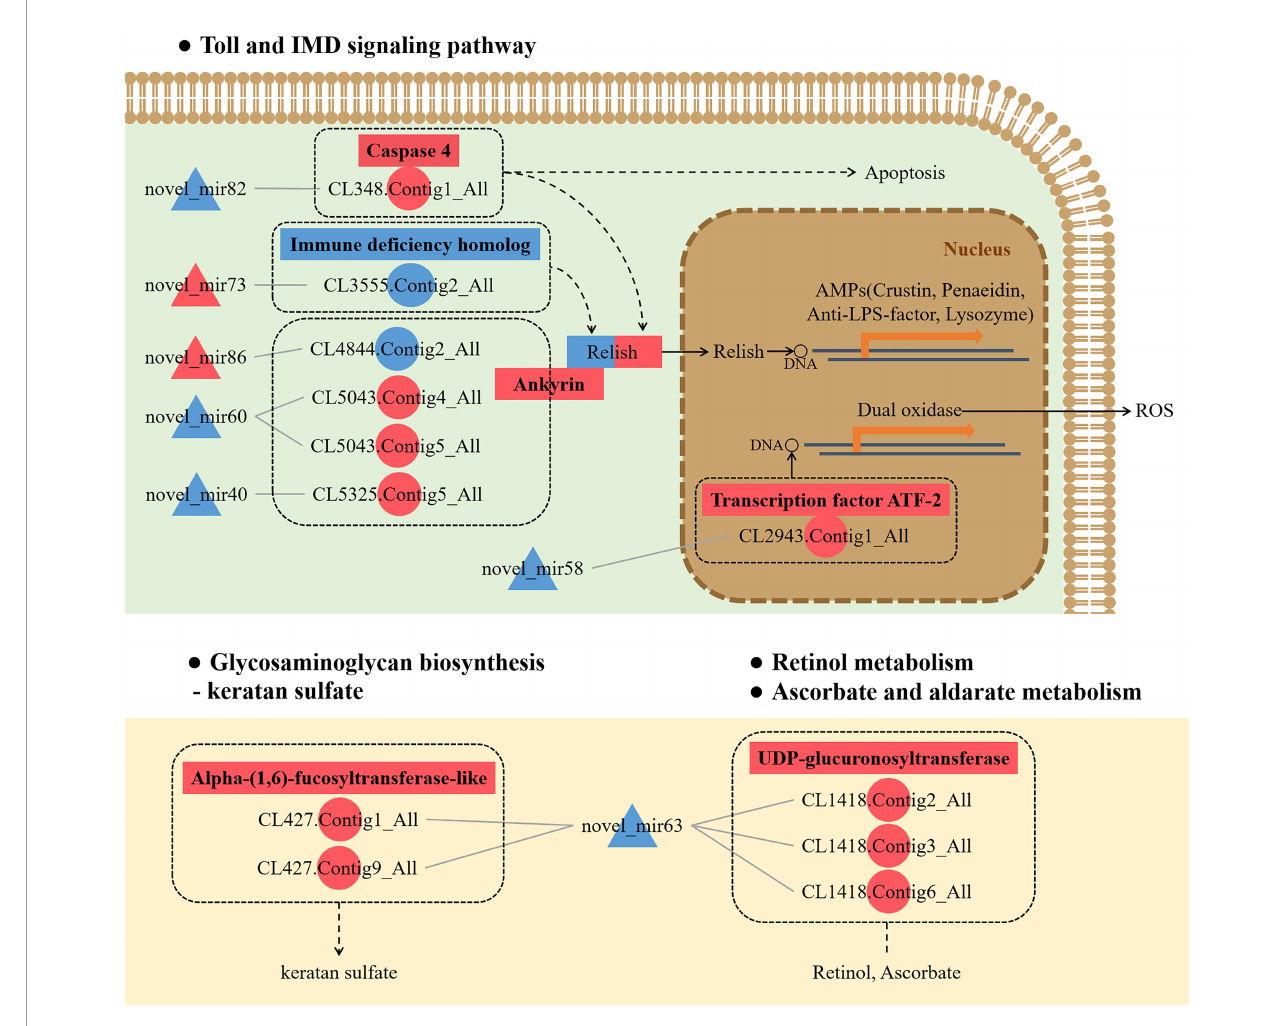
FIGURE 10 | Conceptual diagram of miRNA/mRNA pairs in four potential immune pathways, including the Toll and IMD signaling pathways, Glycosaminoglycan biosynthesis — keratan sulfate, Retinol metabolism, and Ascorbate and aldarate metabolism. Intestinal miRNA can affect the expression of mRNA, thereby regulating apoptosis, AMPs, ROS, keratan sulfate biosynthesis, and VA and VC metabolism, thus resisting DIV1 infection (see the text for detail). Red indicates that genes (miRNAs and mRNAs) were upregulated, and blue indicates that genes (miRNAs and mRNAs) were downregulated. △ represents miRNA, and ○ represents mRNA. AMP, antimicrobial peptide; ROS, reactive oxygen species; VA, vitamin A; VC, vitamin C; DIV1, decapod iridescent virus